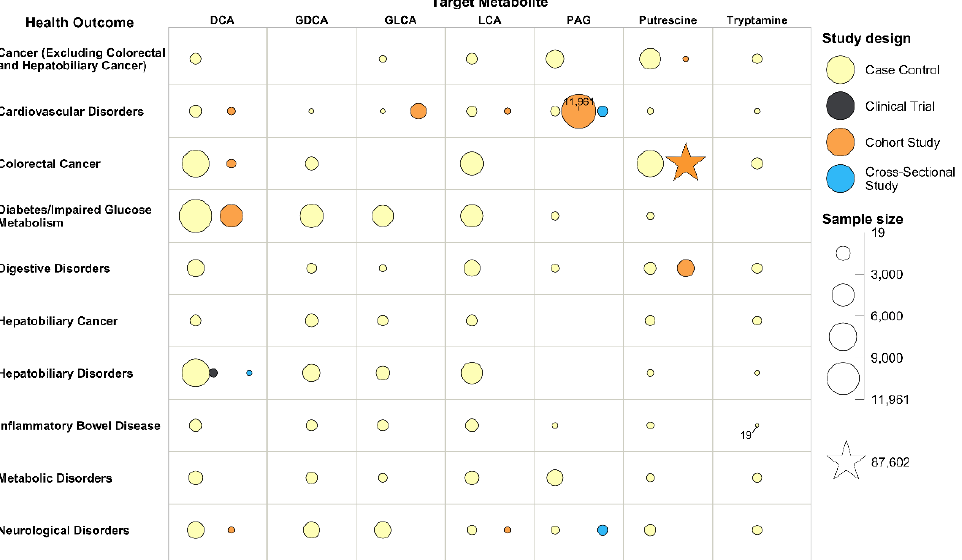
Figure 4. Bubble Plot for Relationships or Pattern between Metabolites, Health Outcomes, and Study Design with Bubble Size Relative to Number of Participants. Abbreviations: DCA: Deoxycholate (De- oxycholic Acid); LCA: Lithocholate (Lithocholic Acid); GDCA: Glycodeoxycholate (Glycodeoxycholic Acid); PAG: Phenylacetylglutamine; GDCA: Glycolithocholate (Glycolithocholic Acid); ManNAc: